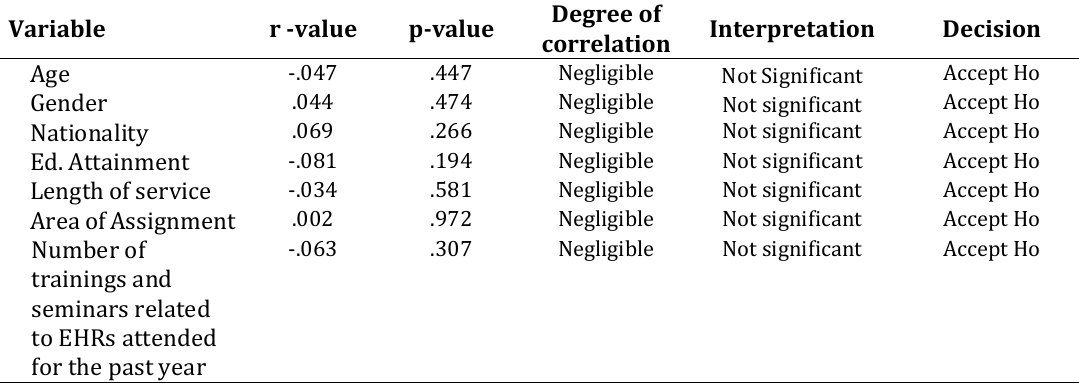
Relationship between profile variables and attitude of nurses Variable r -value